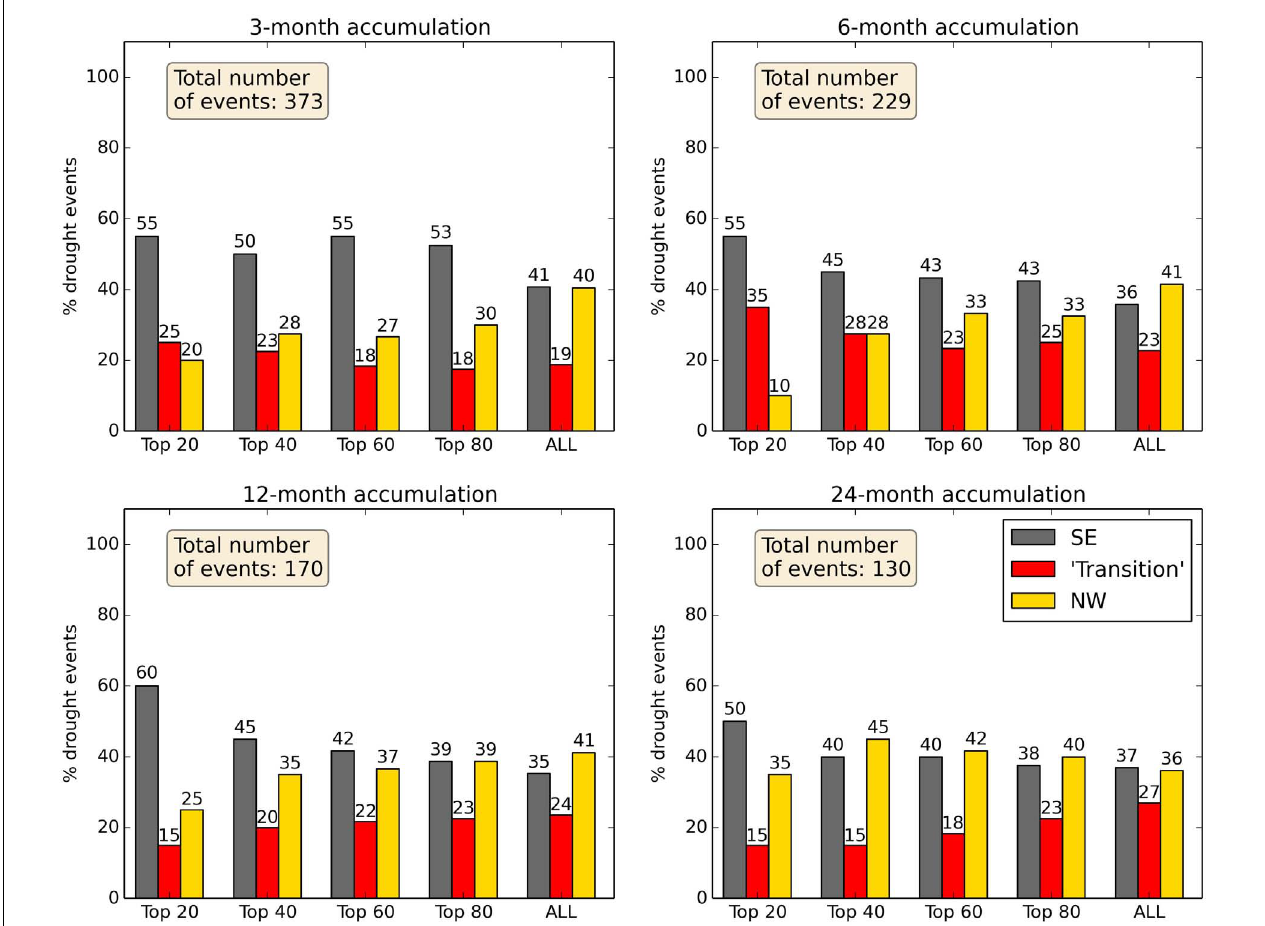
FIGURE 2 | Proportion (in %) of drought events in each region according to drought severity ranking for different accumulation periods. “Top 20,” “Top 40,” “Top 60,” and “Top 80” correspond respectively to the 20, 40, 60, and 80 most severe droughts in GB during our study period (1862–2015). The last set of bars (labelled “ALL”) on each graph include all drought events detected in GB. The events were ranked from most severe to less severe based on the drought severity as defined in Eq.